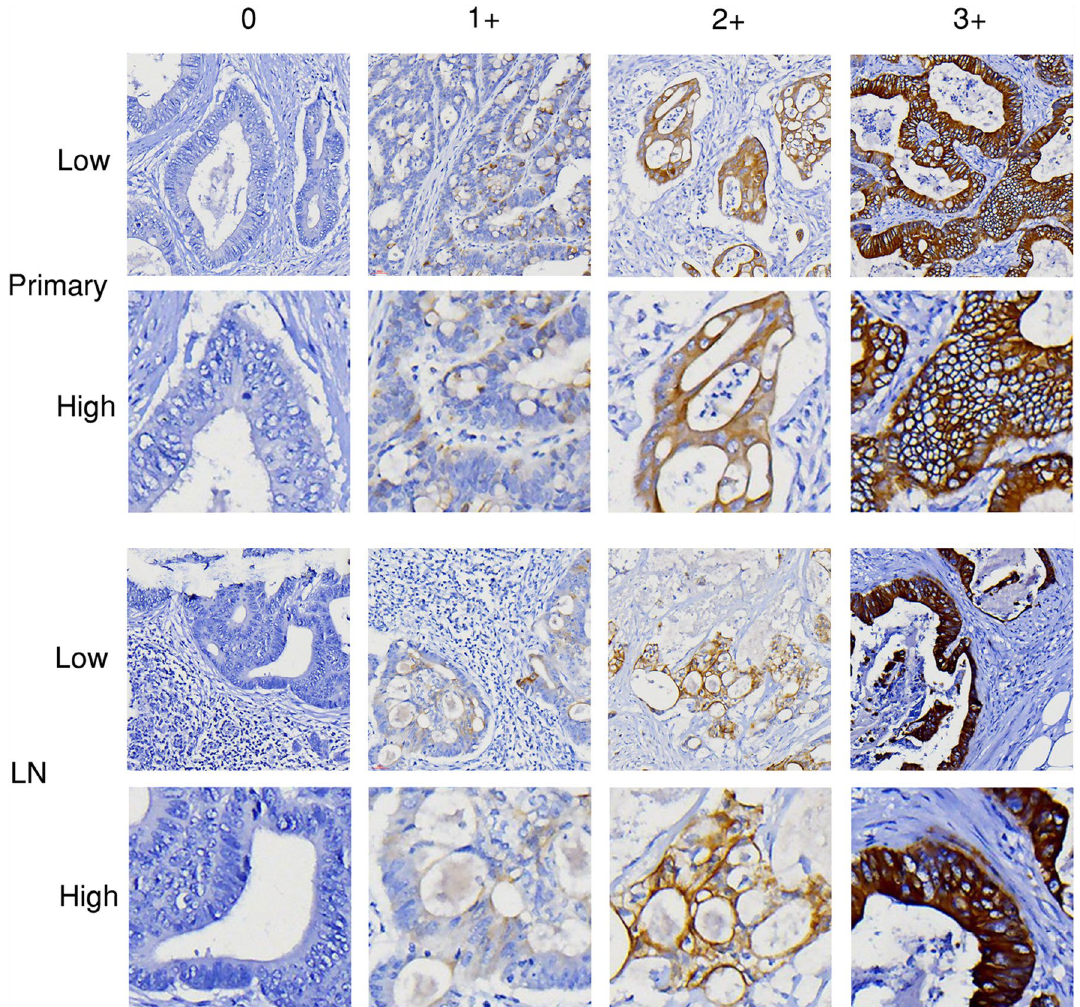
Figure 3. Representative images (HER3 immunohistochemistry staining). Representative images of immunohistochemistry staining scores (0, 1+, 2+, and 3+) for HER3 in primary tumor (Primary) and lymph node metastasis (LN) of CRC. Low: low magnificent power field (× 40); High: high magnificent power field (× 200).